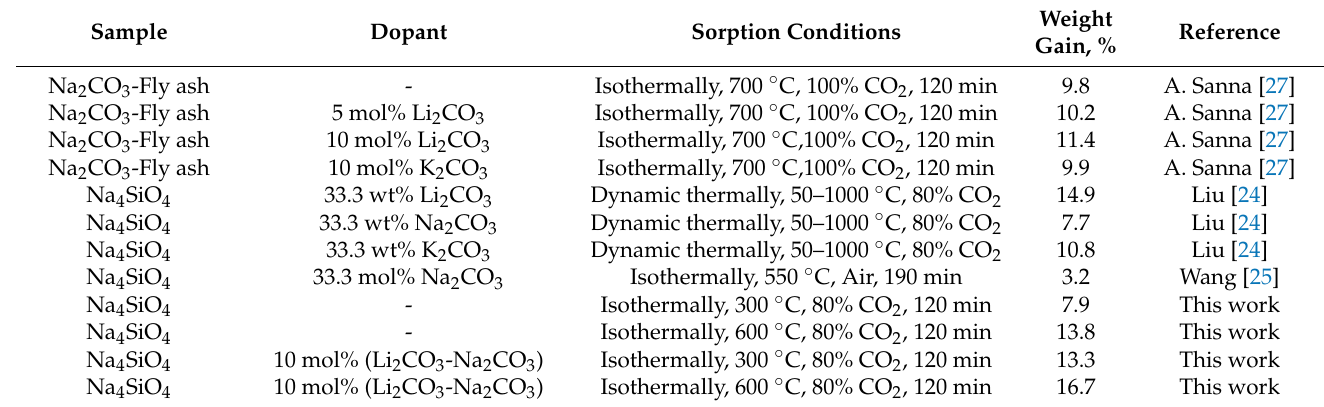
Table 3. Weight gain of Na 4 SiO 4 ‐ based sorbents under different experimental conditions.